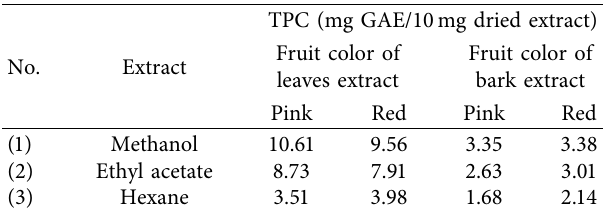
Figure 4: Graph of correlation between the various concentrations of leaves and stem bark extracts of S. aqueum and the mortality of A. salina larvae. Table 5: Lethal concentration 50 (LC Table 6: Total phenolic content (TPC) of leaves and stem bark 50 ) of leaves and stem bark extracts of S. aqueum to A. salina larvae. extracts of S. aqueum with pink and red